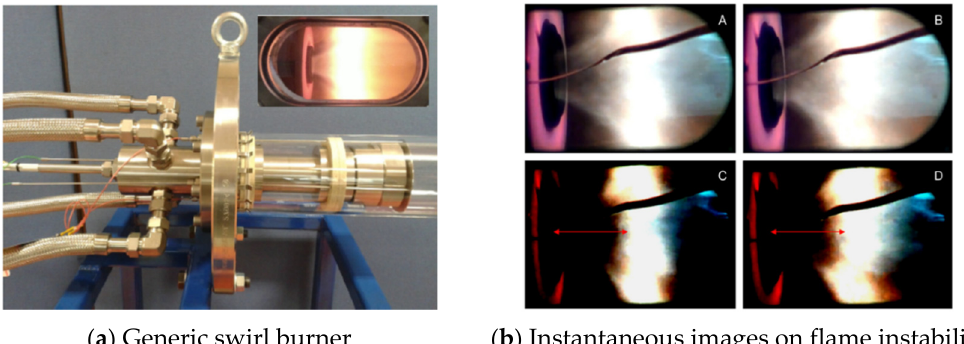
Figure 17. Burner device and visualization results to investigate H 2 -NH 3 mixed combustion characteristics: ( a ) Burner schematic; ( b ) De-convoluted OH intensity at different φ and normalized intensities at highest value ( φ = 1.0). Modified from [97]. Courtesy of Elsevier [97].